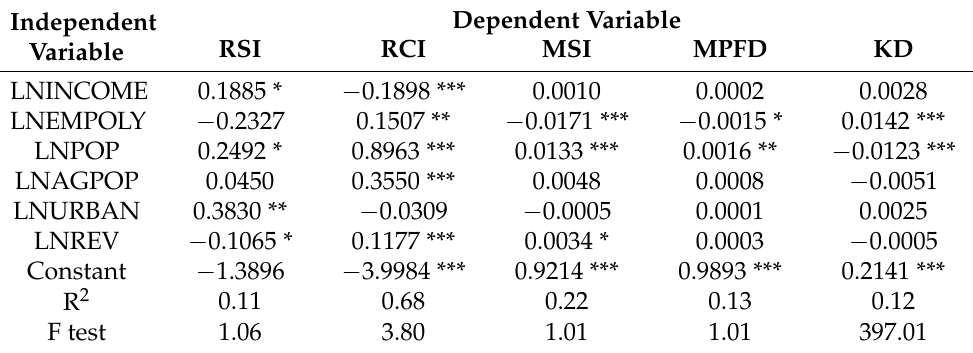
Table 2. Relationships between rural settlement landscape metrics and explanatory